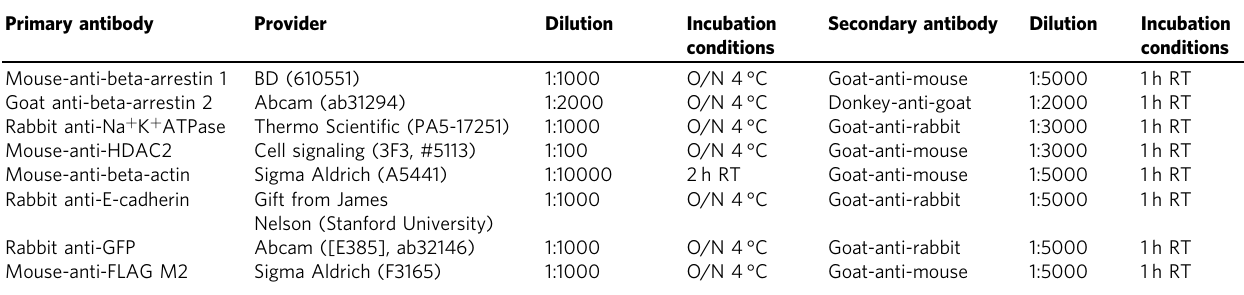
Table 1 Antibody conditions western blot. Primary